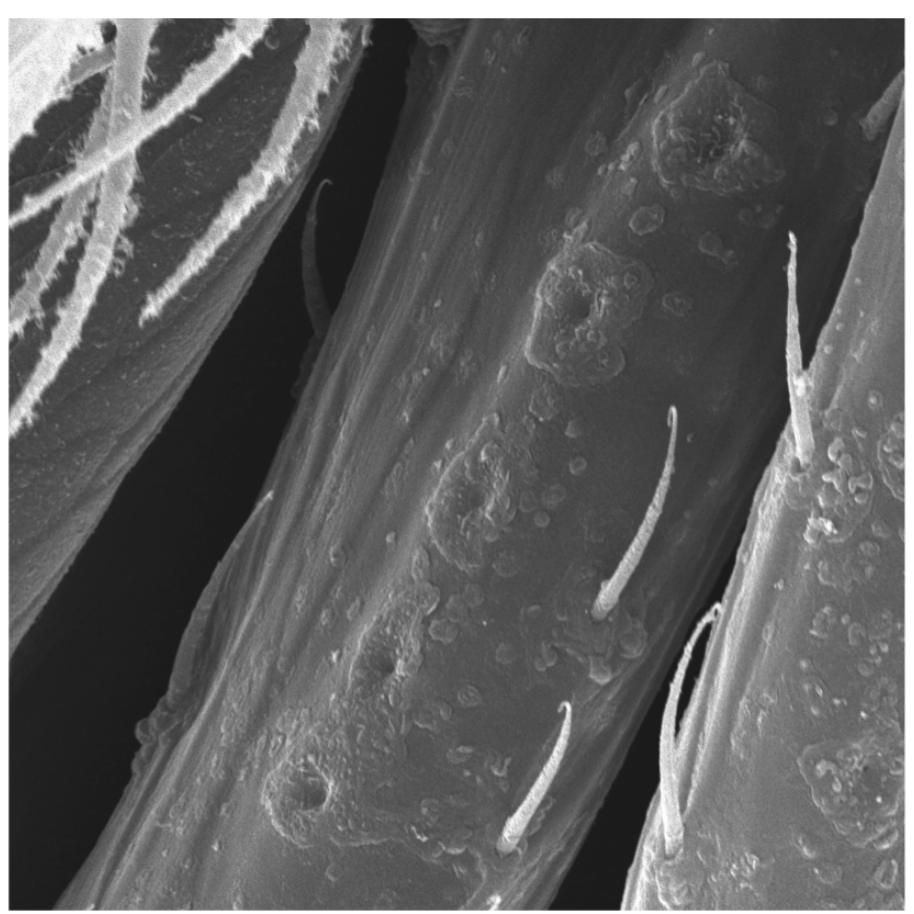
Figure 2. Aphelinus sinensis n. sp., male, scape, ventral view. Note the five linearly arranged exocrine gland